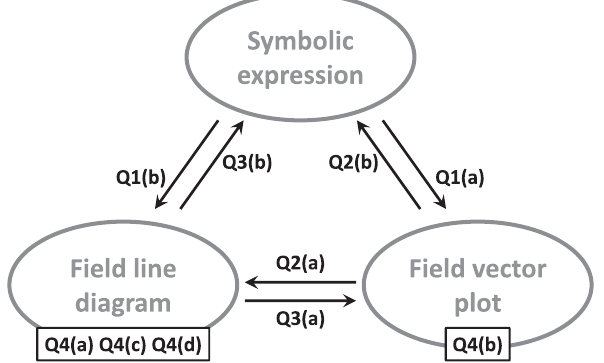
FIG. 2. Overview of the relations between the representations of vector fields and the questions on the VFR